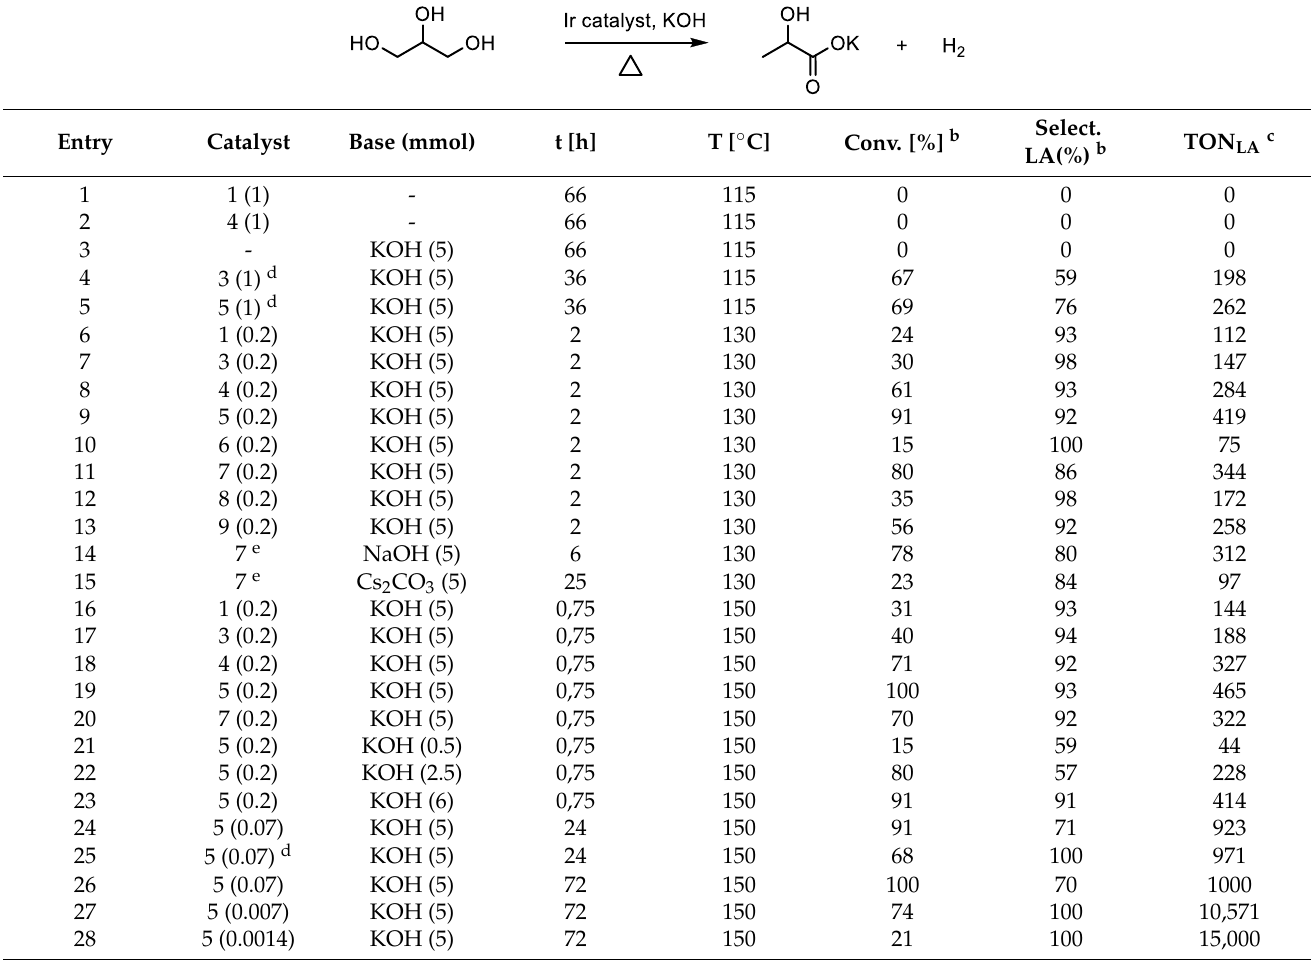
a Standard reaction conditions: glycerol (1 mL, 13.7 mmol), KOH (5 mmol) and iridium catalyst (mol%